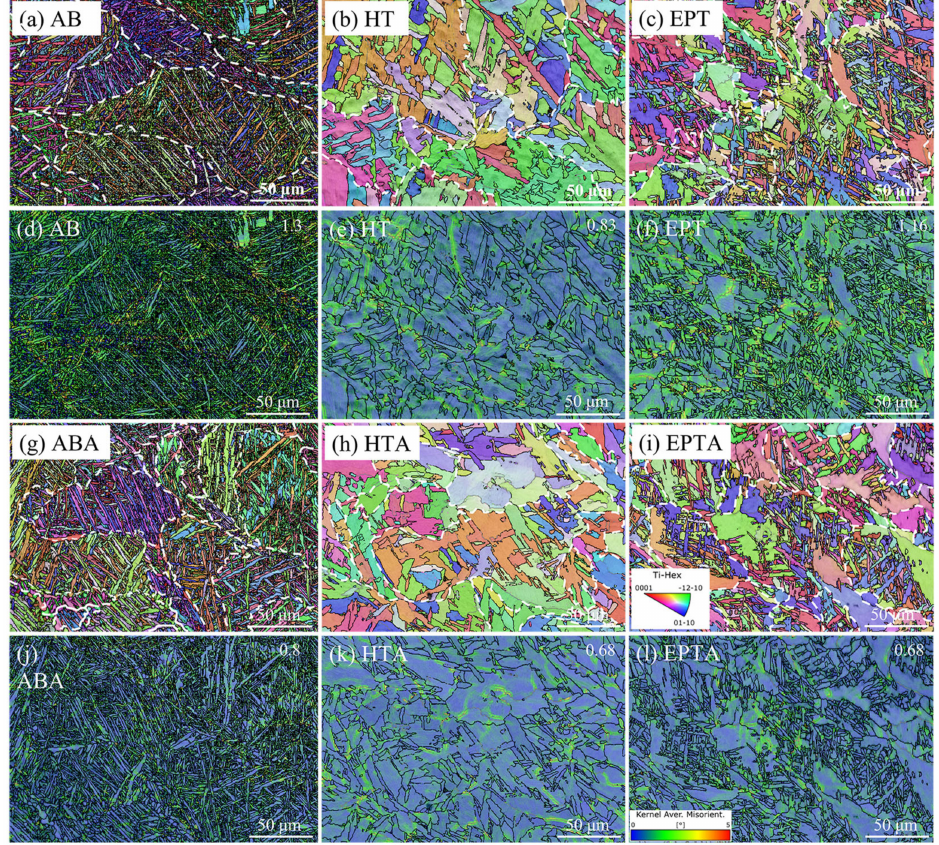
Figure 3. IPF maps and KAM maps of the samples. IPF maps: ( a ) AB, ( b ) HT, ( c ) EPT, ( g ) ABA, ( h ) HTA, ( i ) EPTA; KAM maps: ( d ) AB, ( e ) HT, ( f ) EPT, ( j ) ABA, ( k ) HTA, ( l )